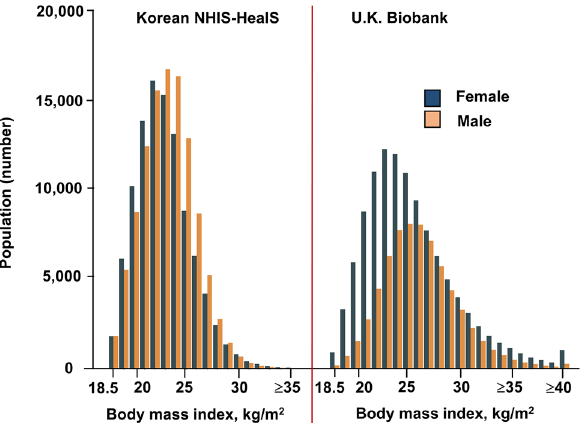
Figure 2. The distribution of participants in the Korean NHIS-HealS and U.K. Biobank cohorts. The cumulative incidence of new-onset AF was higher in the obese and overweight groups than in the normal-